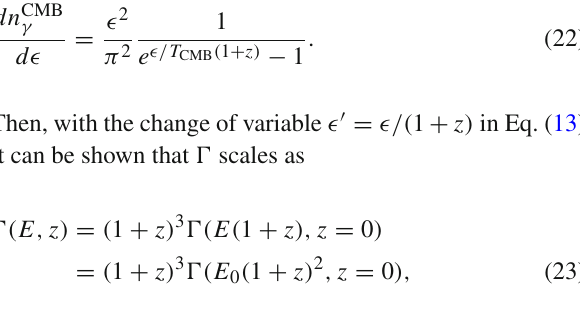
in the cell model, similarly to what happen for the